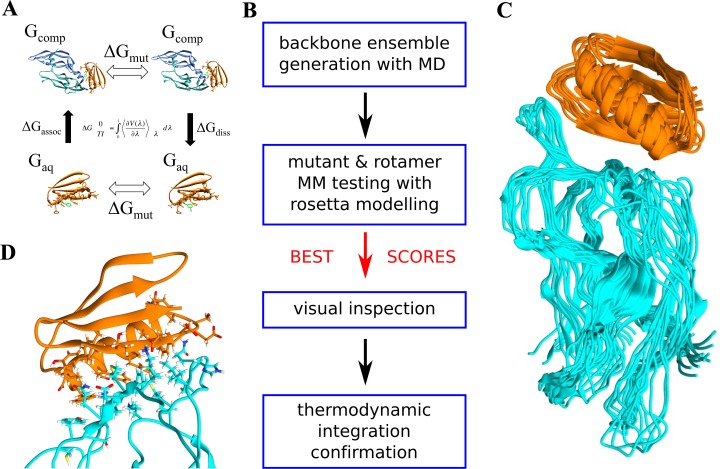
Design process for VEGF inhibiting D-protein with non-canonical amino acids.A: schematic of the four sets of calculations performed in the thermodynamic integration step. Micro-canonical ensembles are generated for both wild type and mutated structures (ΔGmut) in bound and unbound states (ΔGassoc & ΔGdiss). Output energies are integrated using the equation shown to derive ΔG. See TI methods subsection. B: the four main design steps (MM = molecular model). C: complex ensemble generated by MD followed by clustering, representing the explored conformational space; D: interface residues identified for design in atomic resolution.